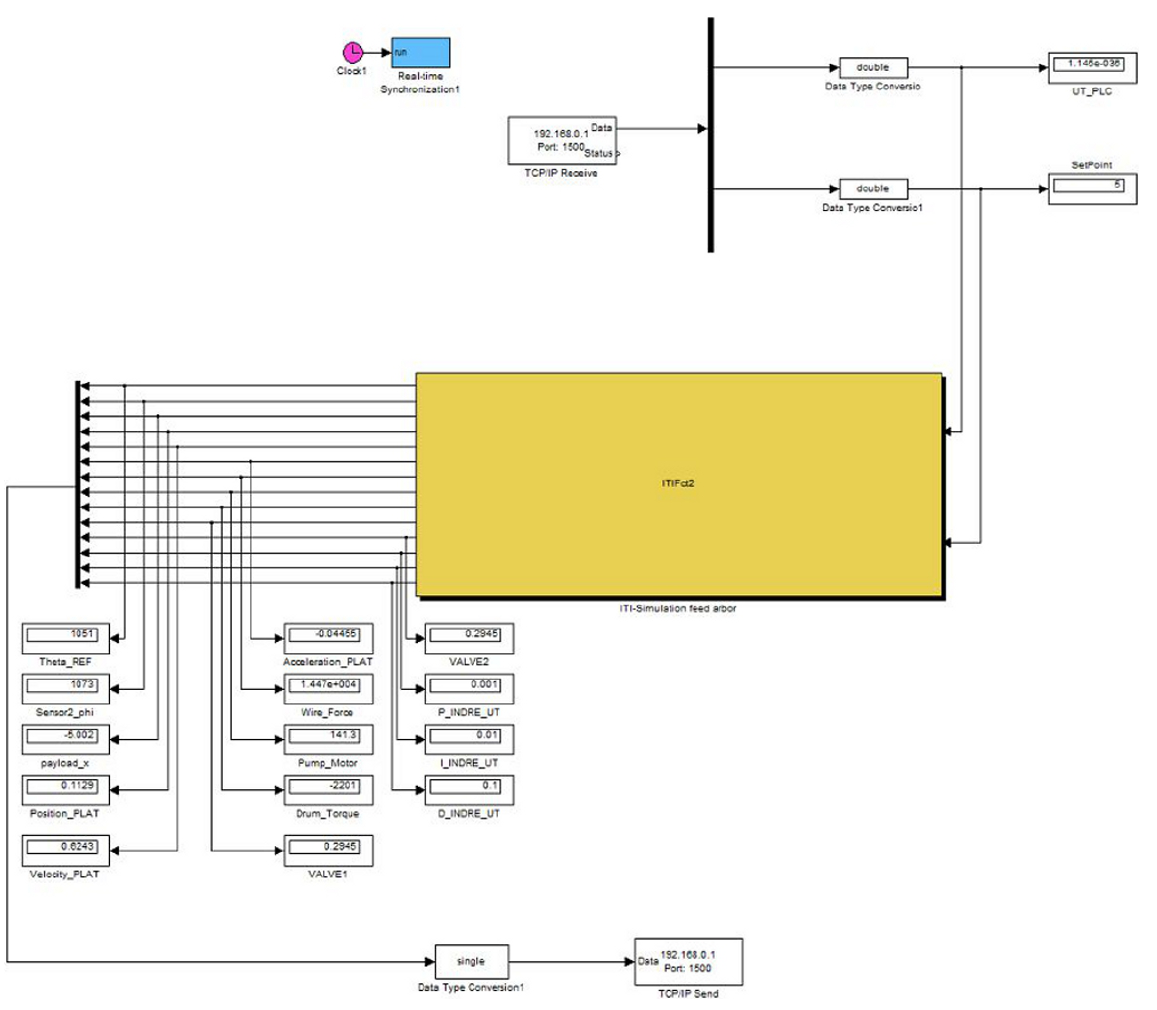
Figure 13. Communication between PLC and model through Simulink .